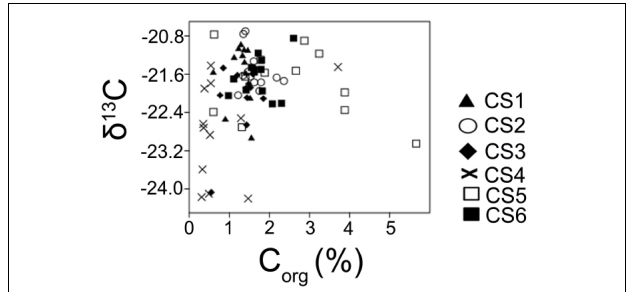
FIGURE 10 | A comparison of observed Corg values and δ 13 C estimated from the surface (0–2 cm) sediment column in order to generate an idea of spatial patterning of carbon in the lagoonal bottom during the study